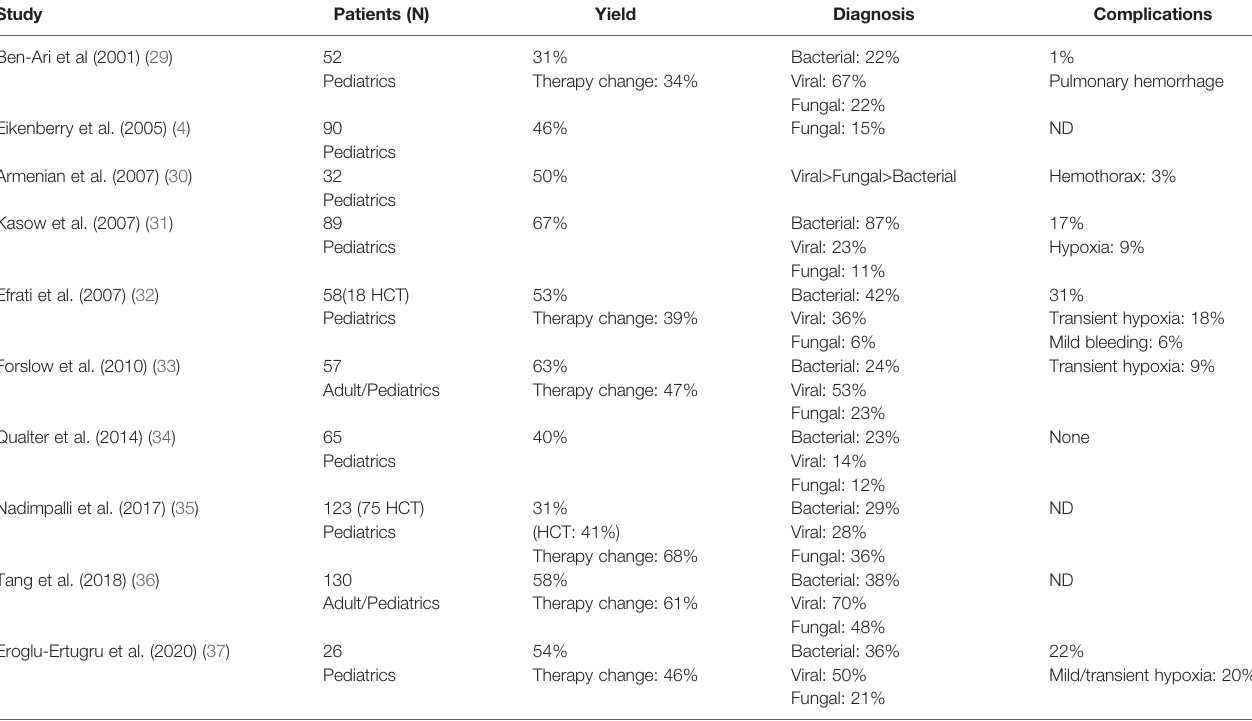
TABLE 2 | Summary of studies evaluating BAL in children post-HCT with pulmonary